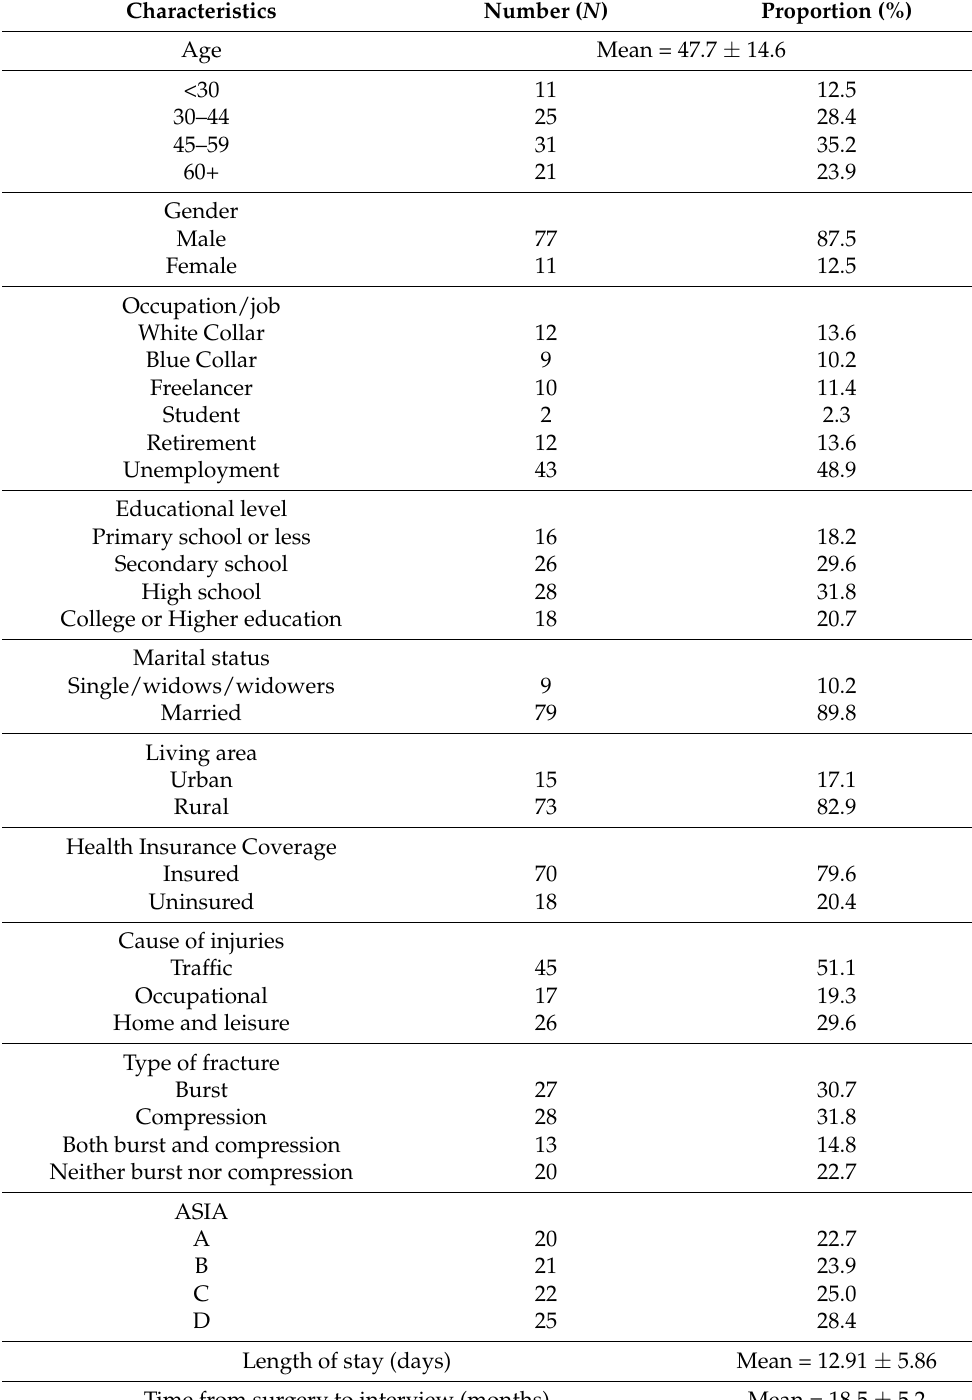
Table 1. Characteristics of